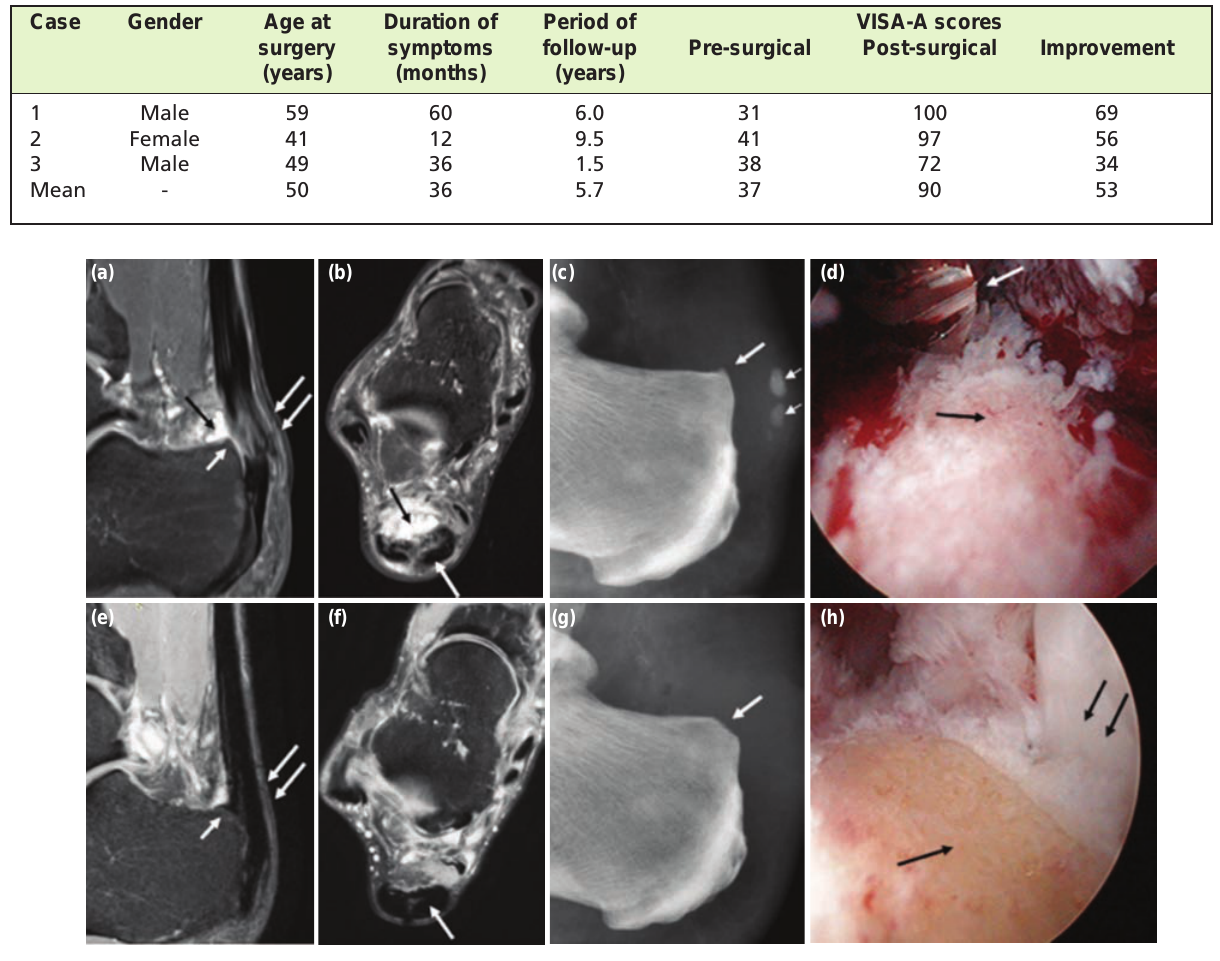
(a) Sagittal and (b) axial proton density fat suppressed (PDFS) MR images of the right ankle showing Haglund's triad with Fig. 1: Haglund deformity (short white arrow), retrocalcaneal bursitis (black arrow) and insertional Achilles tendinopathy (double white arrows). Hyperintense signal and interstitial split tears were noted at the distal Achilles tendon (long white arrows). (c) Lateral ankle radiograph shows Haglund deformity (white arrow) and calcifications in the retro-Achilles bursa (small arrows). (d) Posterior ankle arthroscopic view from the medial portal showing the Haglund deformity (black arrow) and a 4-mm arthroscopic burr (white arrow) from the lateral portal. (e, f) Similar MR images as in (a, b) six years following surgery with burring of previous Haglund deformity (short white arrow), showing repair and regeneration of the Achilles tendon with reversal of the pathology to signal normality (long white arrows). (g) Lateral ankle radiograph following arthroscopic burring of the Haglund deformity (white arrow) and removal of the calcifications in the retro-Achilles bursa. (h) Arthroscopic view similar to (d) following arthroscopic burring of the Haglund deformity (black arrow) revealing the previously impinged Achilles tendon (double black arrows).